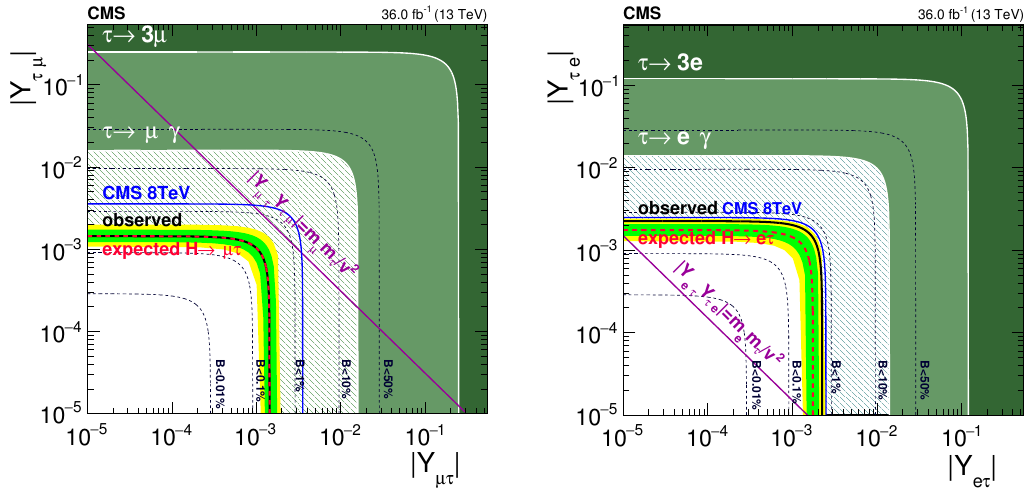
5 − 10 4 − 10 3 − 10 2 − 10 1 − 10 | |Y τ e Figure 10 . Constraints on the (cid:13)avour violating Yukawa couplings, j Y (cid:22)(cid:28) j ; j Y (cid:28)(cid:22) j (left) and j Y e (cid:28) j ; j Y (cid:28) e j (right), from the BDT result. The expected (red dashed line) and observed (black solid line) limits are derived from the limit on B (H ! (cid:22)(cid:28) ) and B (H ! e (cid:28) ) from the present analysis. The (cid:13)avour- diagonal Yukawa couplings are approximated by their SM values. The green (yellow) band indicates the range that is expected to contain 68% (95%) of all observed limit excursions from the expected limit. The shaded regions are derived constraints from null searches for (cid:28) ! 3 (cid:22) or (cid:28) ! 3e (dark green) [41, 92, 93] and (cid:28) ! (cid:22)(cid:13) or (cid:28) ! e (cid:13) (lighter green) [41, 93]. The green hashed region is derived by the CMS direct search presented in this paper. The blue solid lines are the CMS limits from [44] (left) and [45] (right). The purple diagonal line is the theoretical naturalness limit j Y ij Y ji j (cid:20) m i m j =v 2